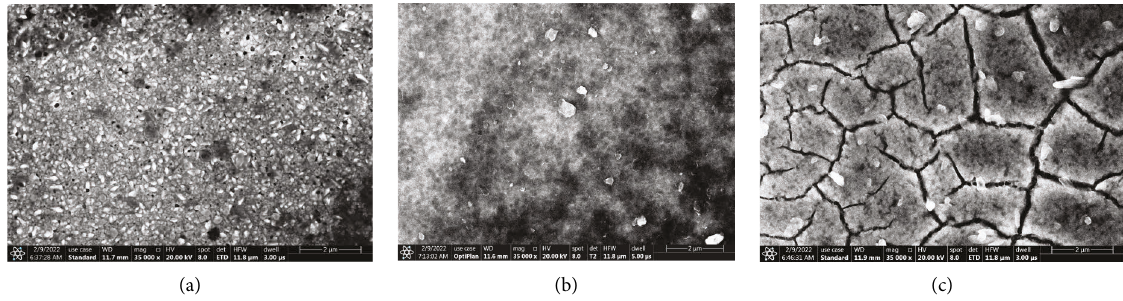
Figure 9: SEM surface morphology images of electroplated corten steel (a) Cu coated (b) Zn coated (c) Ni